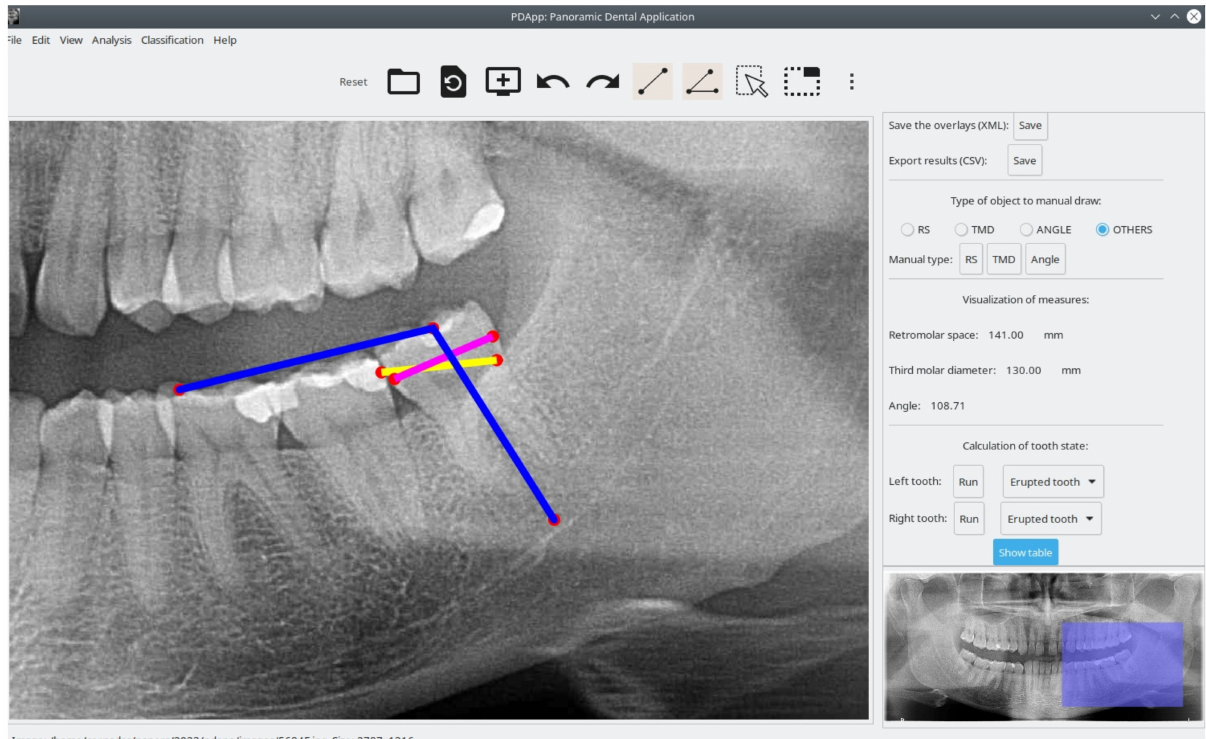
Figure 4. Visual example of a third molar erupted, predicted correctly by PDApp. The pink line represents third molar diameter, the yellow line represents retromolar space, and blue lines represent the angle of